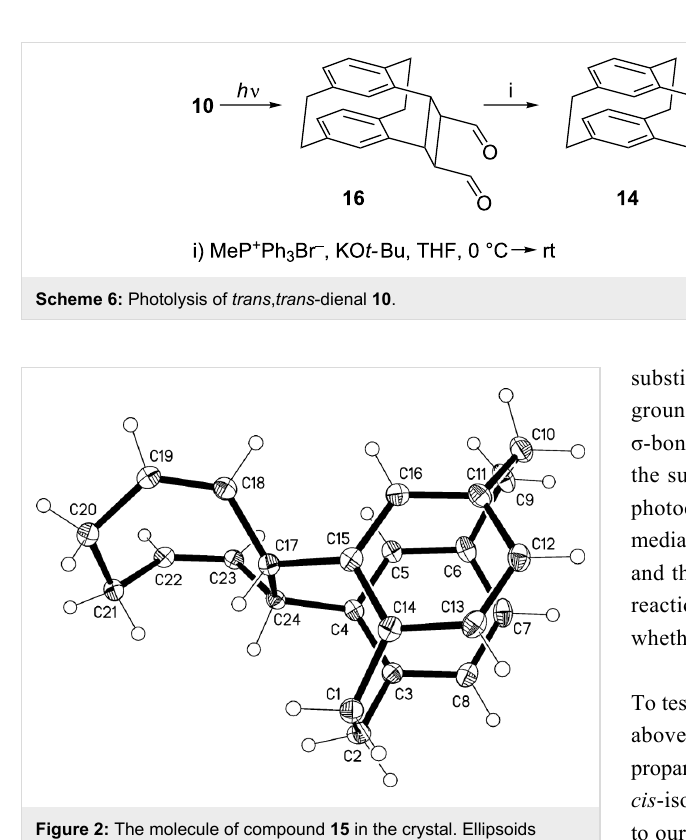
e.g., the short contact H18 … H1A 1.91 Å; compound 15 has no intramolecular H … H < 2